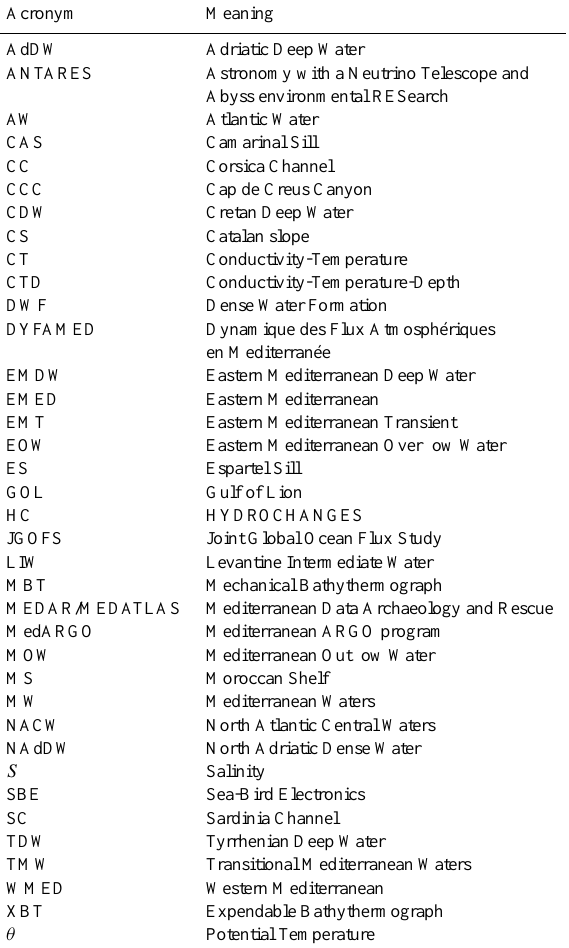
Table 1. List of acronyms used in the